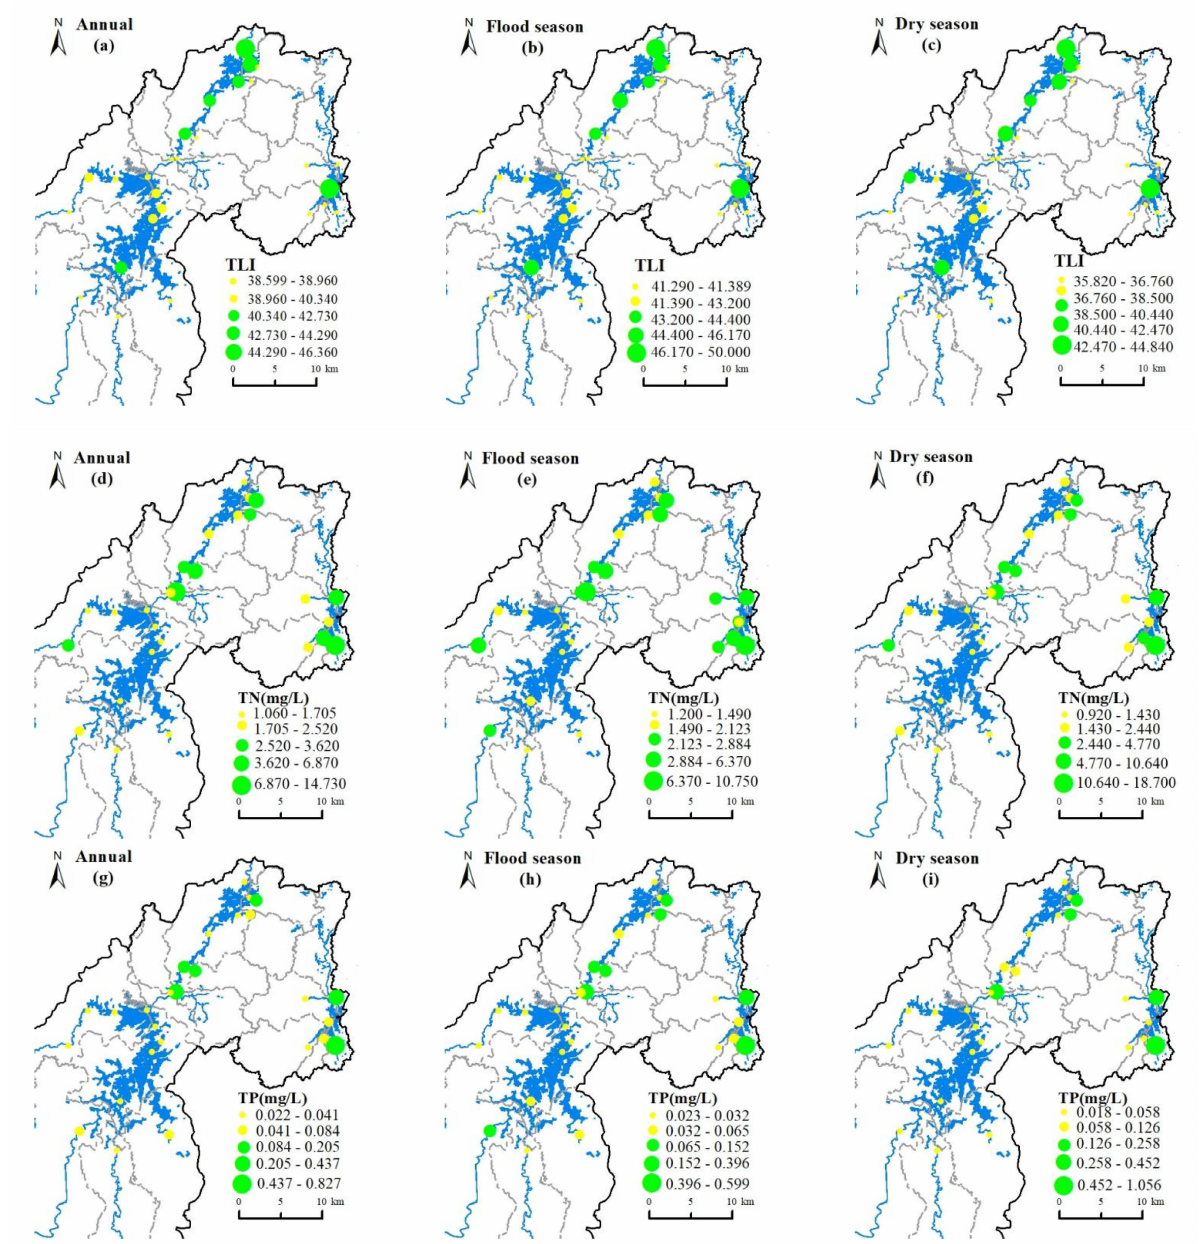
Figure 5. Spatial distributions of TLIs ( top row ), TN concentrations ( center row ), and TP concentra- tions ( bottom row ). ( a , d , g ) Annual; ( b , e , h ) flood Season; ( c , f , i ) dry